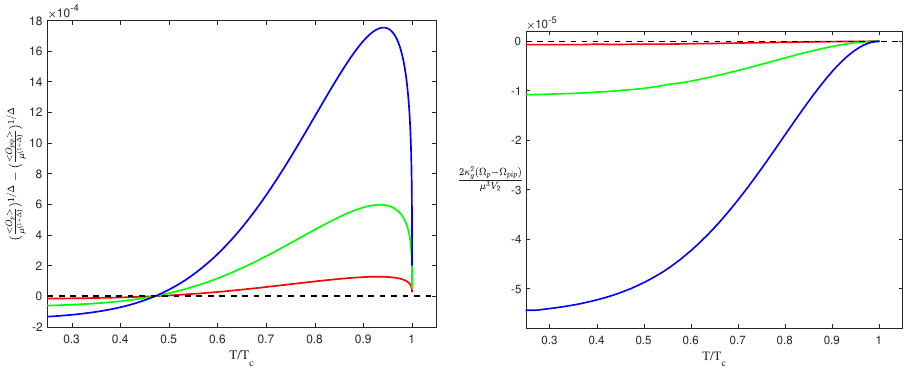
Figure 2 . Difference of condensate(left plot) and grand potential density(right plot) between the p-wave and p+ip solutions with b = 0 . 1 (red line), 0 . 2 (green line), 0 . 3 (blue